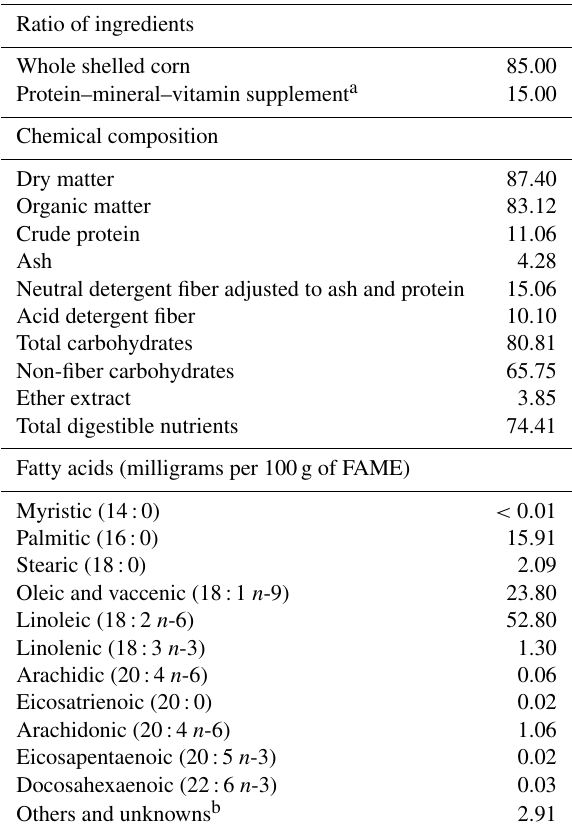
Table 1. Ratio of ingredients and chemical composition (%; dry matter, DM, basis) of the diet. Ratio of